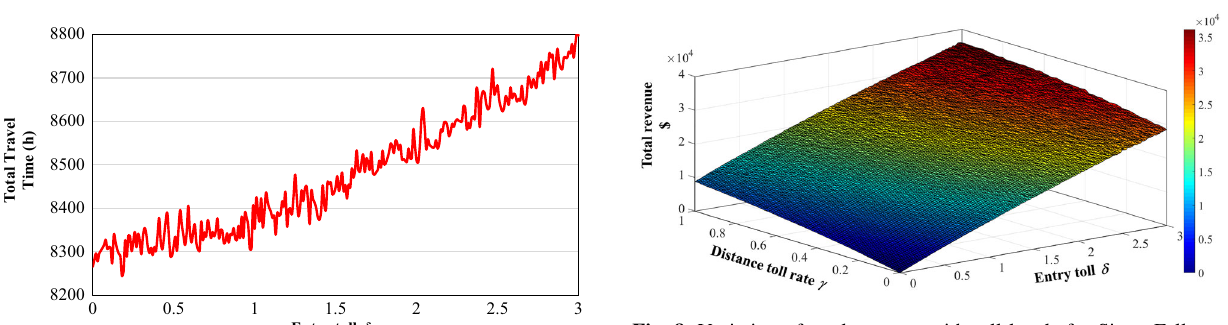
Fig. 8 Variation of total revenue with toll levels for Sioux